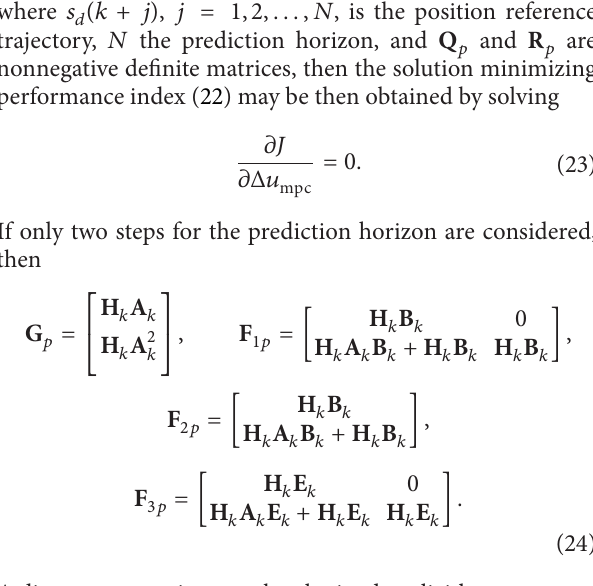
Figure 6: Working phases one and two (fed by 𝑈 𝑠 ).